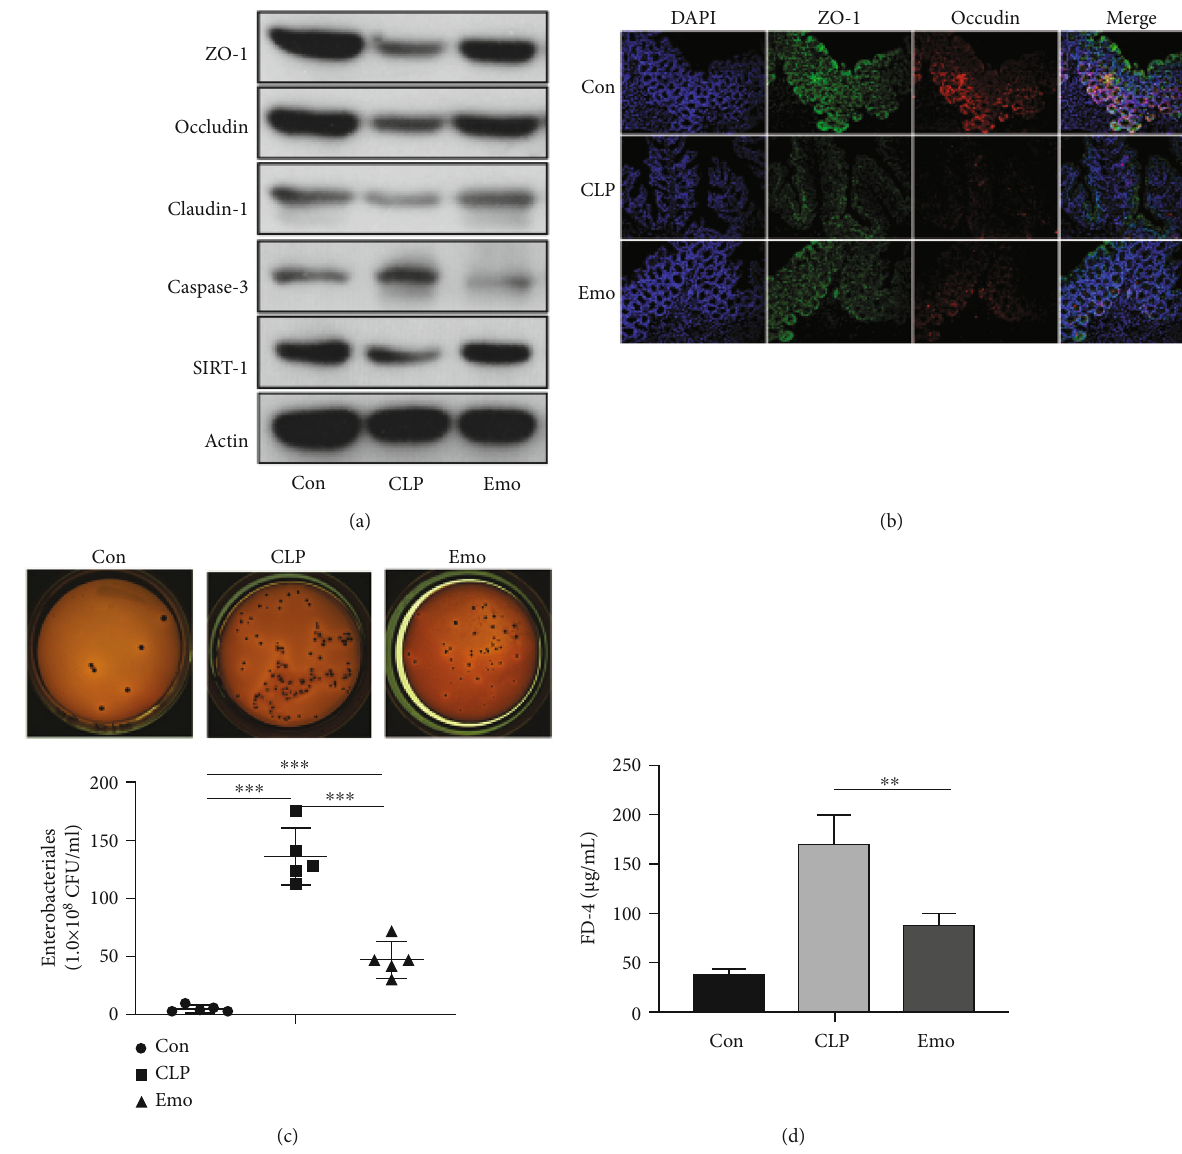
Figure 3: Emodin restored the intestinal barrier function of septic mice. (a) Regulatory e ff ect of emodin on ZO-1, occludin, claudin-1, cleaved caspase-3, and SIRT-1. (b) Immuno fl uorescence on ZO-1 and occludin by using confocal microscopy. (c) Determination of E. coli transplanted colonies in MLNs. Statistics of bacterial colonies in the mesenteric lymph nodes of mice in each group by counting CFU (colony-forming unit). ∗ p < 0 : 05 , ∗∗ p < 0 : 001 , and ∗∗∗ p < 0 : 001 with comparisons indicated by lines ( n = 5 per group). (d) E ff ects of emodin on intestinal permeability in CLP mice. Intestinal permeability was determined by detecting plasma FD4. Data are presented as means ± SEM from three independent experiments, and di ff erences between mean values were assessed by one-way